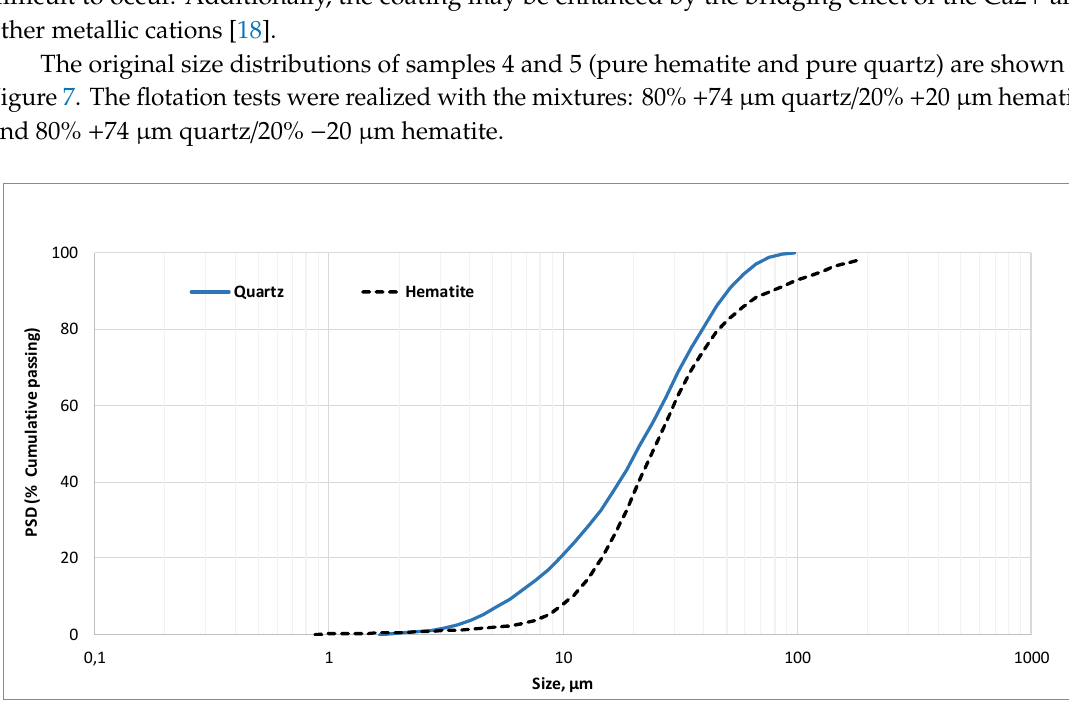
Figure 7. PSD of the pure samples of hematite and quartz (samples 4 and 5).